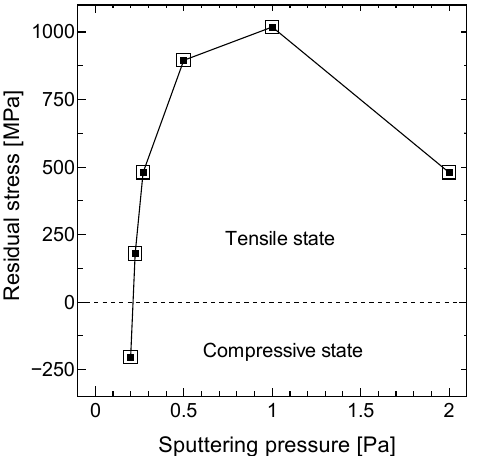
Figure 5. Fabrication flow of the electrothermal kirigami MEMS scanner: ( a ) SiO 2 /SiN film with an approximately 30 MPa compressive strength was deposited by plasma-enhanced chemical vapor deposition (PECVD). ( b ) W patterns were deposited by lift-off processes. ( c ) NiCr films with 180 MPa tensile residual stress were deposited by sputtering and patterned by wet etching. ( d ) After PR patterning, microscale kirigami cuttings were placed on SiN film by reactive-ion etching (RIE). ( e ) After Cr mask patterning and PR removal, the Si substrate was etched by the backside DRIE to form the SiO 2 /SiN film. ( f ) Freestanding SiN kirigami film on which NiCr and W patterns were deposited was formed by SiO 2 removal with vapor hydrofluoric acid (HF) etching.